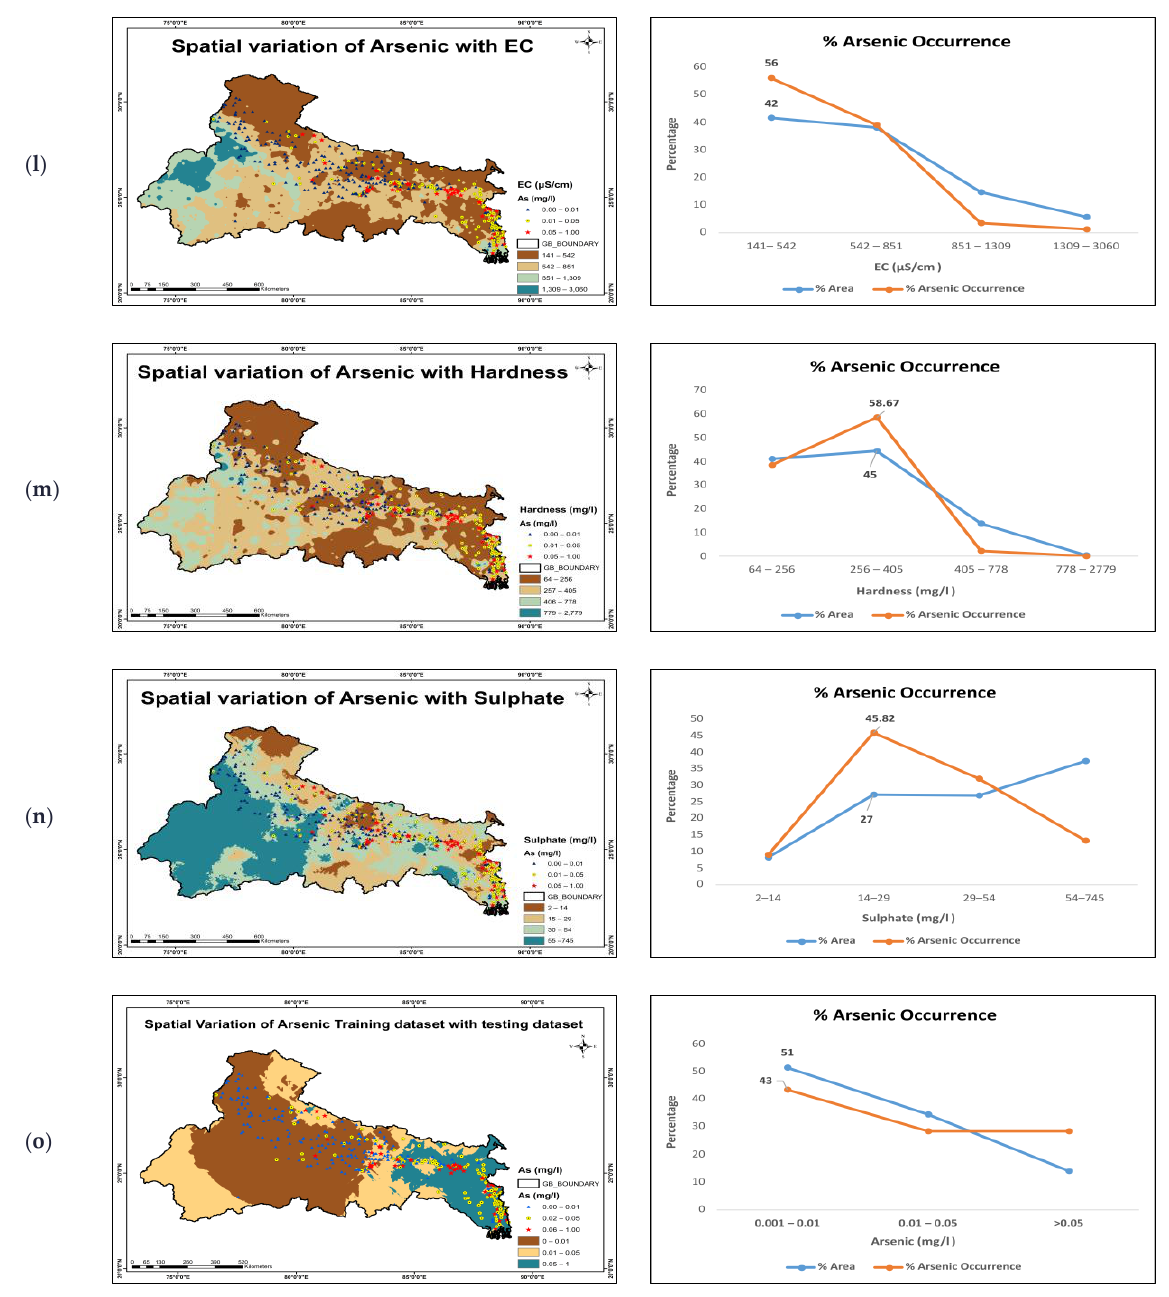
Figure 3. Thematic layers and arsenic occurrence percentages w.r.t.: ( a ) DTW; ( b ) slope; ( c ) geomorphology; ( d ) types of aquifers; ( e ) soil types; ( f ) LULC; ( g ) rainfall; ( h ) groundwater abstraction; ( i ) dissolved silica; ( j ) bicarbonate; ( k ) iron; ( l ) EC; ( m ) hardness; ( n ) sulphate; and ( o ) testing arsenic datasets of the study area.